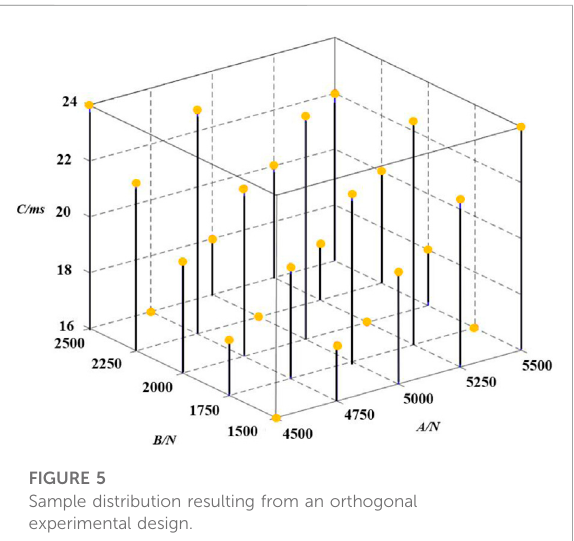
FIGURE 5 Sample distribution resulting from an orthogonal experimental